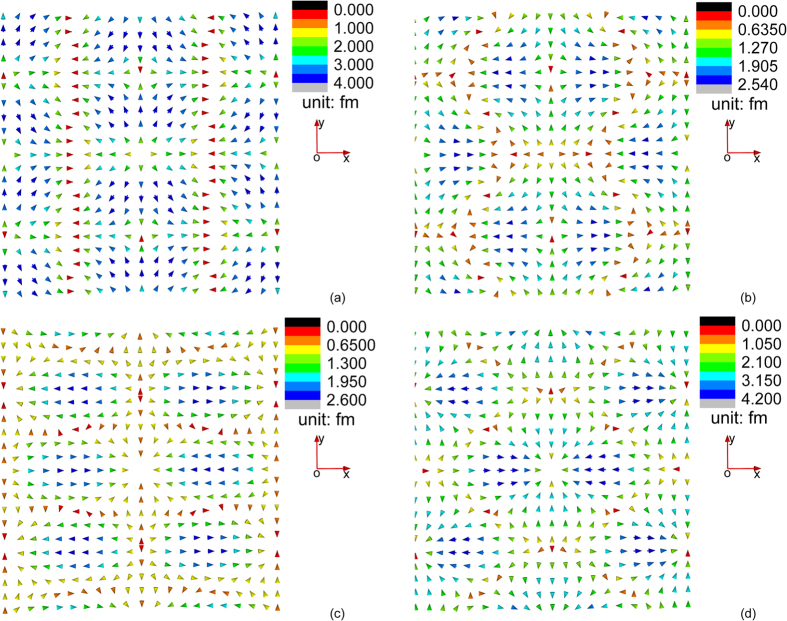
Configuration of uS1 at temperature 4 K and magnetic field (a) 0.1 T, (b) 0.2 T, (c) 0.3 T, and (d) 0.4 T.